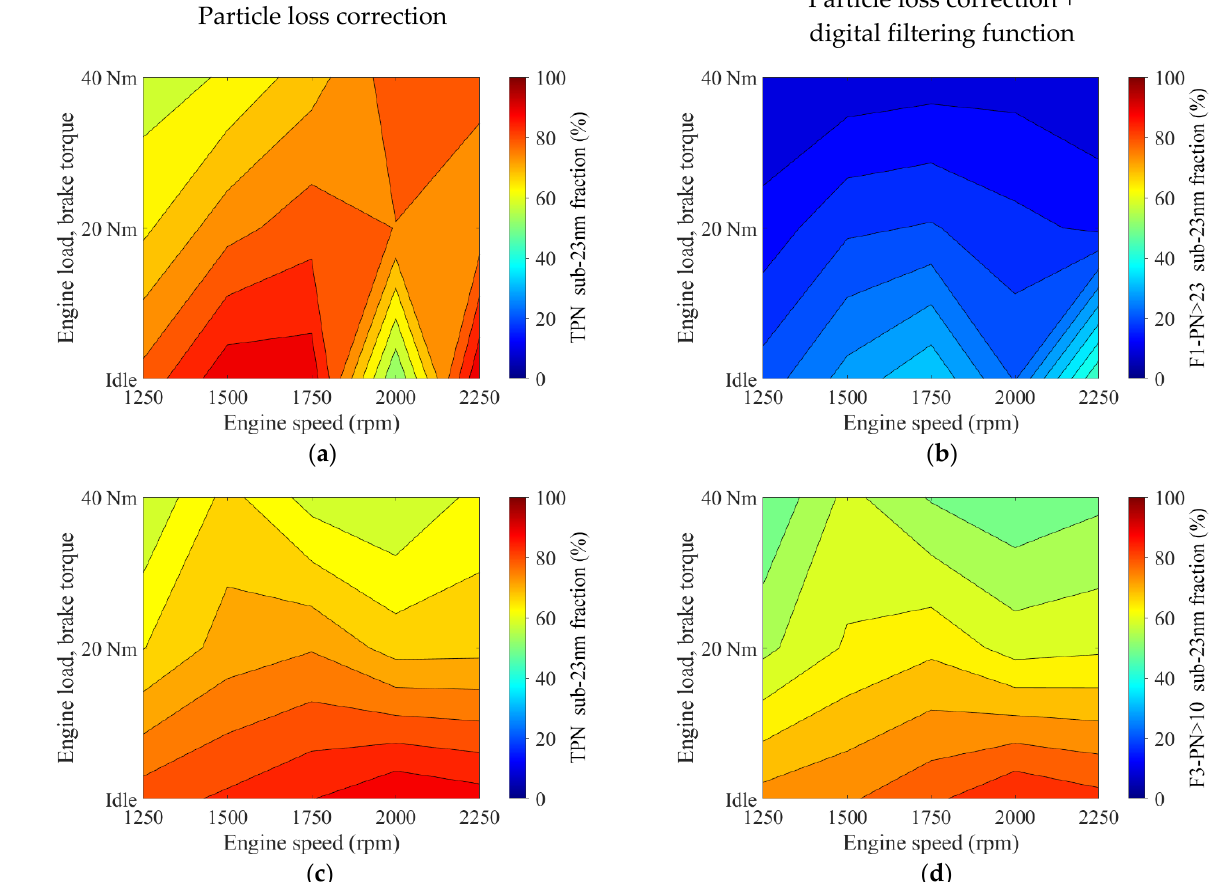
Figure 7. Fraction of sub-23 nm particles by engine speed and load for DMS measurements with and without catalytic stripper (CS) in subfigures ( c , d ) and ( a , b ), respectively. The data displayed in subfigures ( a , c ) has been particle loss corrected. The data displayed in subfigures ( b , d ) has been digitally filtered in addition to the particle loss correction. For the digital filtering, Equation (1) was applied for F1-PN > 23 and Equation (3) for F3-PN > 10.